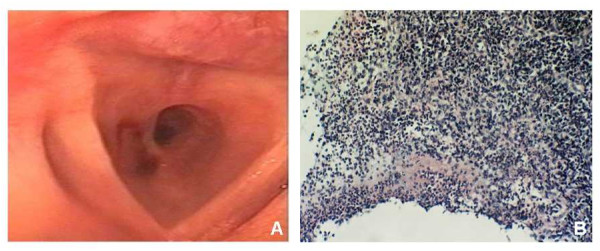
Fiberoptic bronchoscopy and histological examination of tracheal stenosis. (A) Circumferential tracheal stenosis, greater than 70%, 1–2 cm beneath the vocal cords and marked inflammation of tracheal mucosa was noted at fiberoptic bronchoscopy. (B) Histological examination revealed acute and chronic inflammation and extended ulceration of bronchial mucosa, without granulomas.